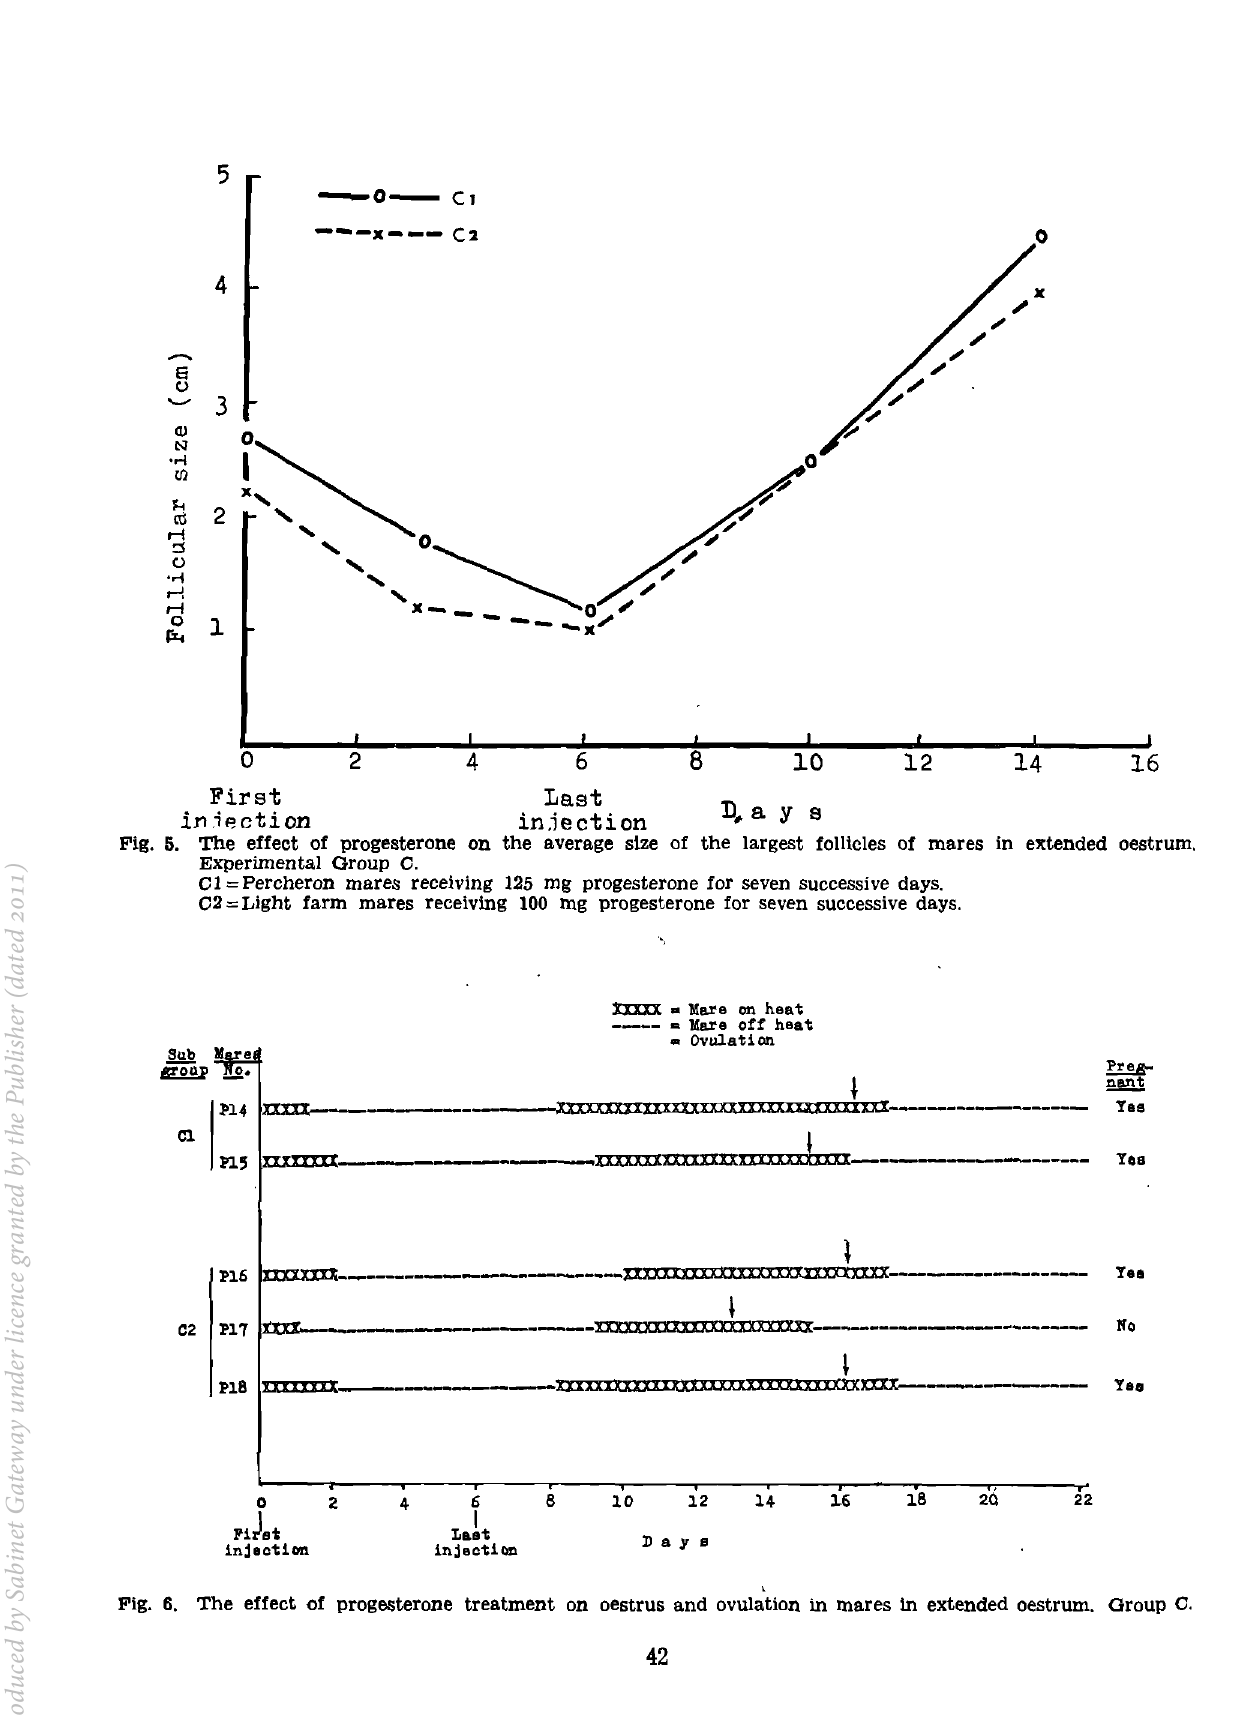
Fig. 6. The effect of progesterone treatment on oestrus and ovulation in mares in extended oestrum. Group O.